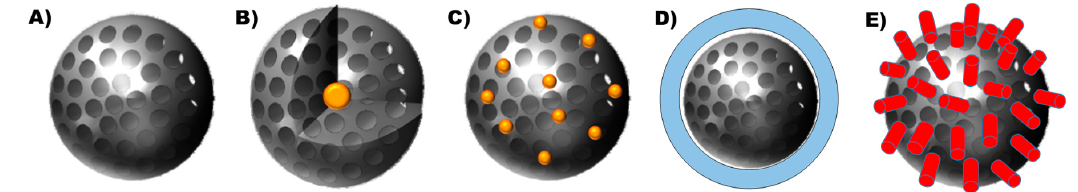
Figure 2. The most common types of mesoporous silica materials (MSM) in the form of nanoparticles (MSNPs) that are used as drug delivery systems: ( A ) bare MSNPs; ( B ) (metal or other material NP core) @ (mesoporous silica shell); ( C ) metal NPs/MSNPs; ( D ) MSNPs coated with a polymer shell and ( E ) molecule functionalized-MSNPs.